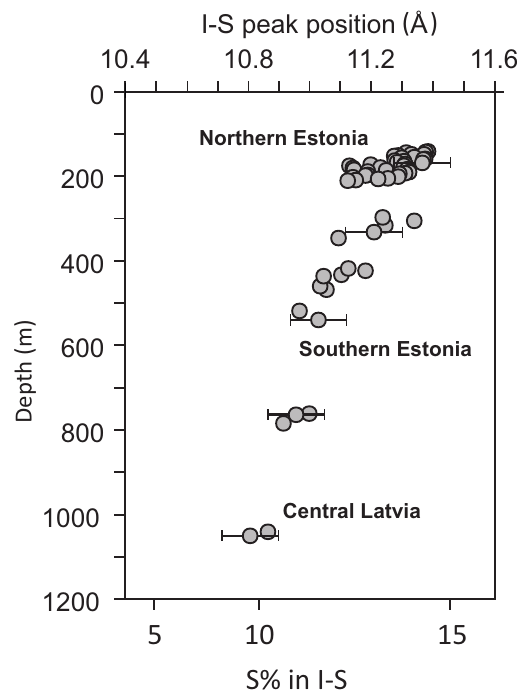
Fig. 4. Change in d ­values with the sampling depth for the decomposed illite­smectite (I­S) mixed­layer mineral and the change in the content of smectitic layers (S%) in illite­ smectite. The estimated standard deviation for the I­S peak position determination shown in the figure is in the range of 0.1–0.2